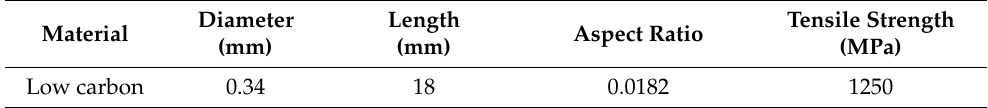
Table 3. The geometrical and mechanical properties of the steel